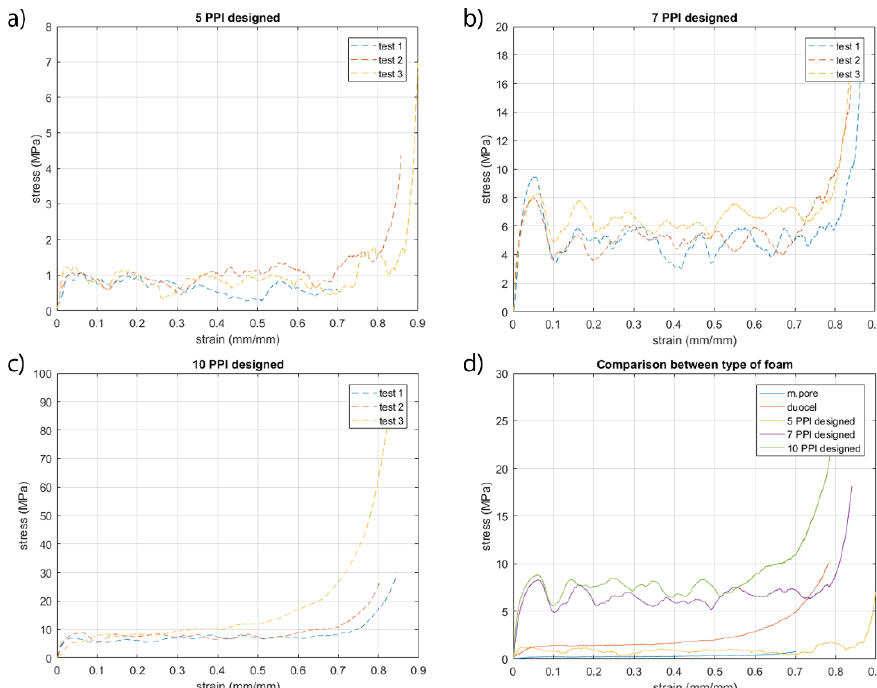
Figure 7. Stress-strain curves of designed foams. Respectively, ( a ) 5 PPI designed, ( b ) 7 PPI designed, c ) 10 PPI designed, and d ) comparison between type of foams investigated. Table 2. Results of compression tests.